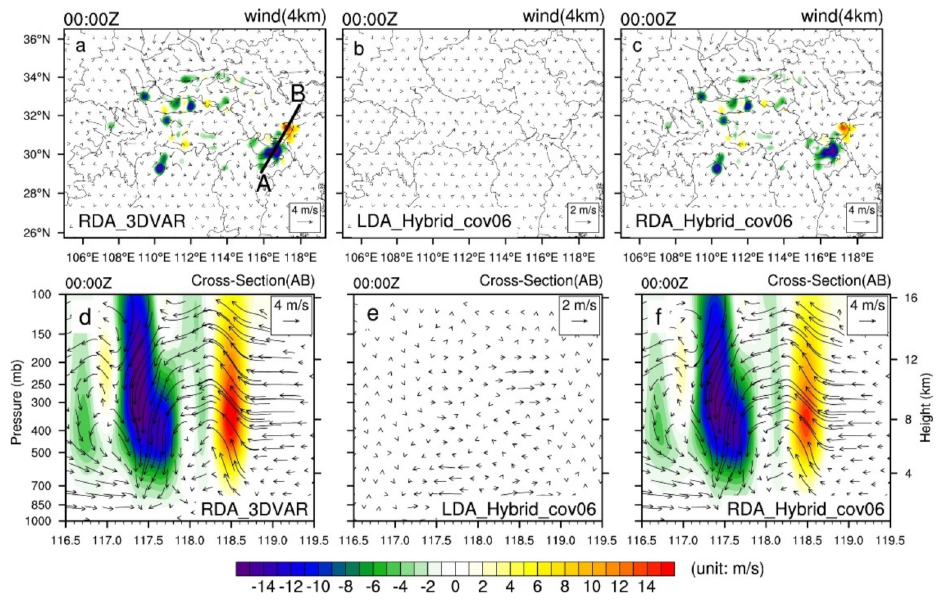
Figure 4. Horizontal increments of vertical velocity (shaded contours) and wind vector (black vector arrows) from single-analysis experiments at z = 4 km ( a – c ) and vertical-cross sections of increments of vertical velocity and wind vector ( e – f ) at 0000 UTC 30 June 2018 (analysis time) along line AB in ( a ). The line AB in ( a ) is the same position as the line AB in Figure 3a. Lightning data assimilation by hybrid 3DEnVAR ( b , e ), radar data assimilation by 3DVAR ( a , d ) and hybrid 3DEnVAR ( c , f ). The black lines AB in ( a ) denote the locations of the vertical cross-sections for ( d – f